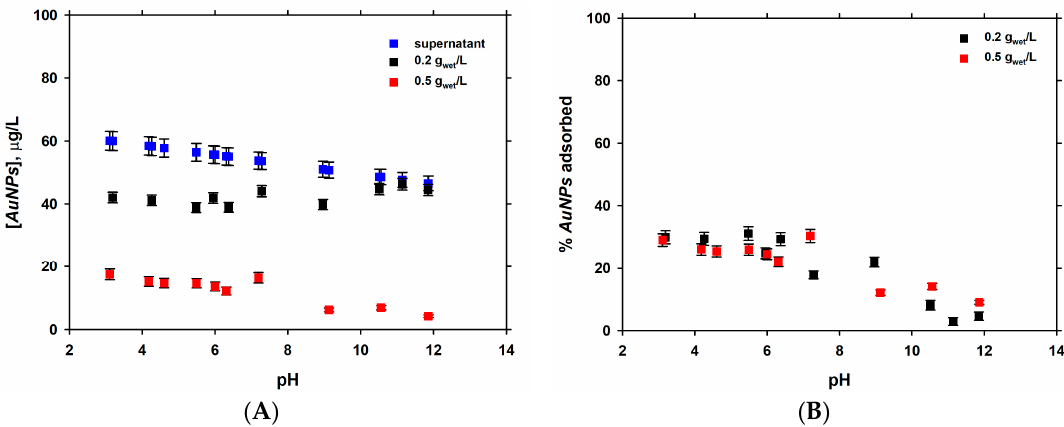
Figure 3. ( A ) The final concentration of AuNPs measured after 60 min in cell-free supernatant and in contact with 0.2 and 0.5 g wet /L of diatoms; and ( B ) the percentage of adsorbed AuNPs as a function of pH. The error bars are within the symbol size unless shown. They correspond to standard deviation of duplicates.